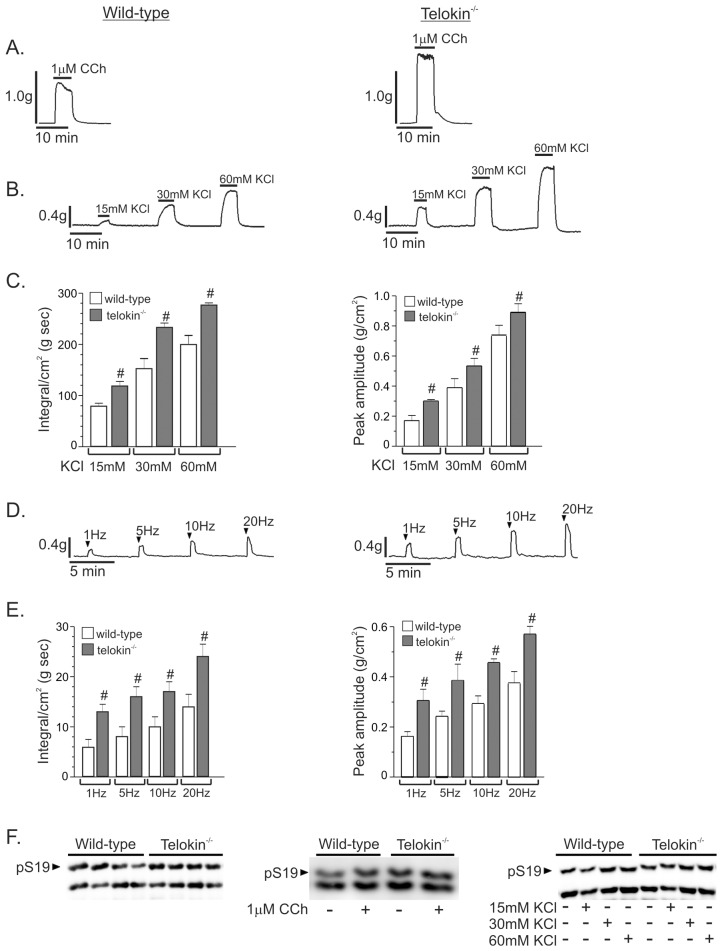
The contractile responses of telokin-/- gastric fundus smooth muscles are increased compared to wild-type controls.A. Representative recordings of the contractile responses of wild-type and telokin-/- gastric fundus smooth muscles to 1μM CCh (n = 4). B. Representative recordings of the contractile responses of wild-type and telokin-/- gastric fundus smooth muscles to 15mM, 30mM, and 60mM KCl. C. Average integrals and peak amplitudes of contraction ± SD of wild-type and telokin-/- gastric fundus smooth muscles to 15mM, 30mM, and 60mM KCl (#
P<0.05 compared to wild-type, n = 8). D. Representative recordings of the contractile responses of wild-type and telokin-/- gastric fundus smooth muscles incubated with 100μM LNNA and 1μM MRS2500 to 30 sec of 1Hz, 5Hz, 10Hz, or 20Hz EFS. E. Average integrals and peak amplitudes of contraction ± SD of wild-type and telokin-/- gastric fundus smooth muscles incubated with 100μM LNNA and 1μM MRS2500 to 30 sec of 1Hz, 5Hz, 10Hz, or 20Hz EFS KCl (#
P<0.05 compared to wild-type, n = 4). F. Representative western blots of phosphorylated and non-phosphorylated MLC in wild-type and telokin-/- gastric fundus smooth muscles.